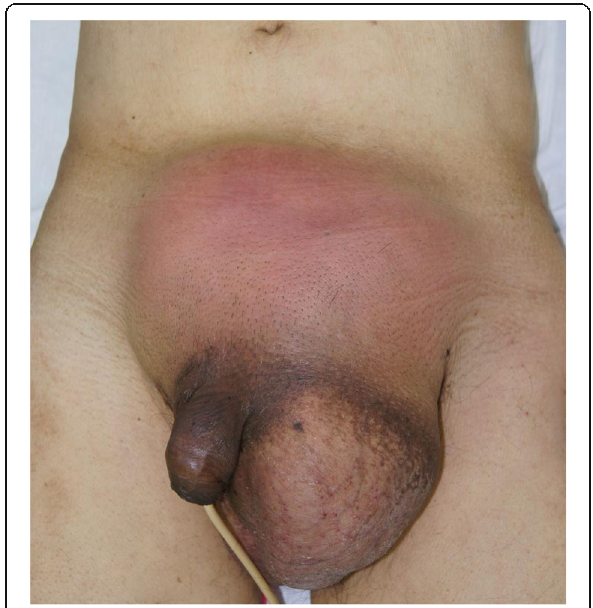
Fig. 1 Appearance of the lower abdomen and groin on admission